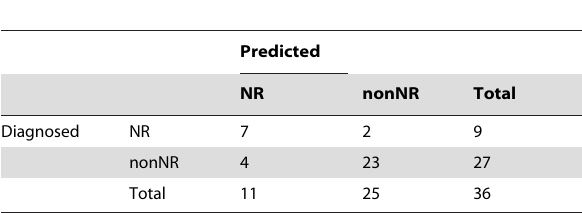
Table 7. Quality of NR-prediction by DLDA with IFN related gene and IL28B polymorphism A.IFN + IL28B.